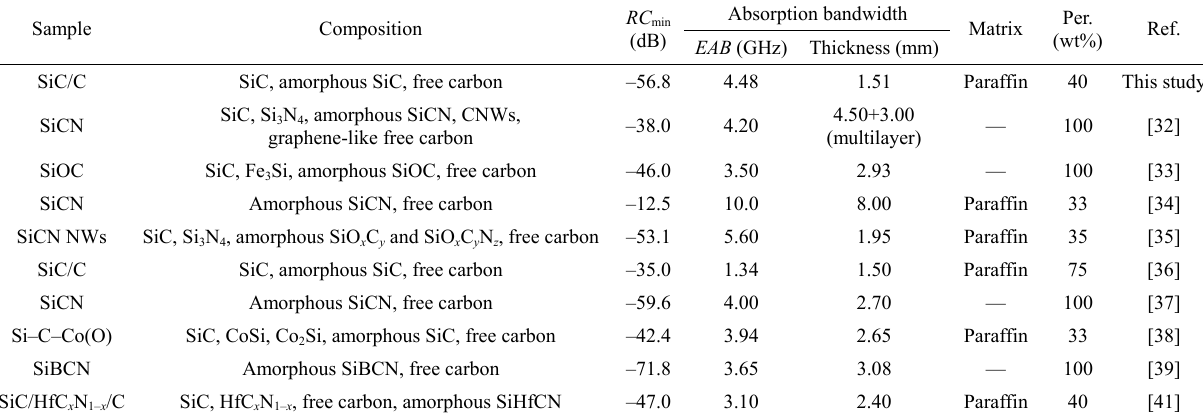
Fig. 11 Schematic illustration of EMW absorption for carbon-rich SiC/paraffin wax composites. Table 3 Summary of EMW absorption properties for various PDCs containing in-situ formed free carbon in